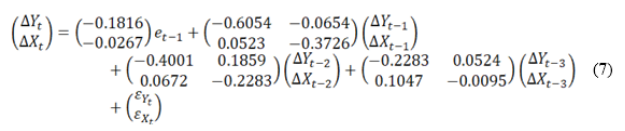
Table 3. Likelihood ratio test for lag